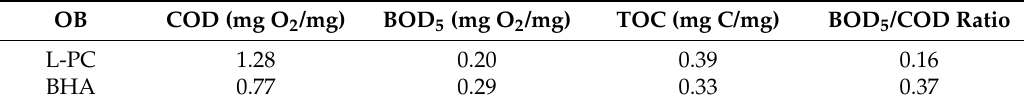
Table 1. Organic load obtained per dry weight of Optical Brighteners